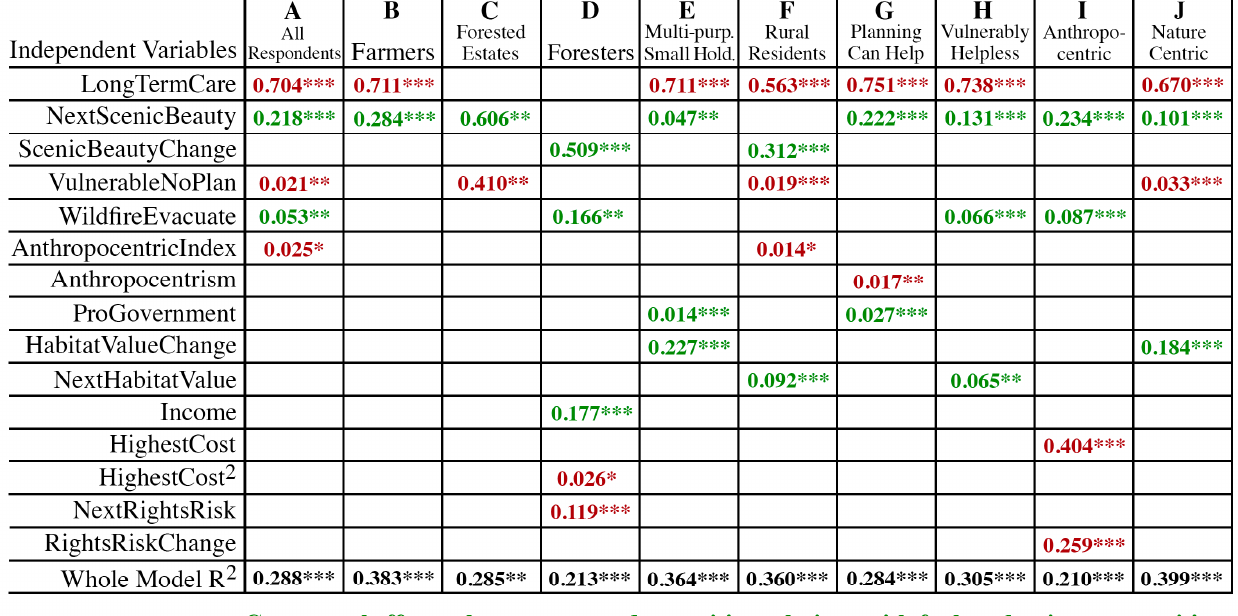
Figure 11. Total effects of variables (rows) in predicting project propensities across respondent types (columns).